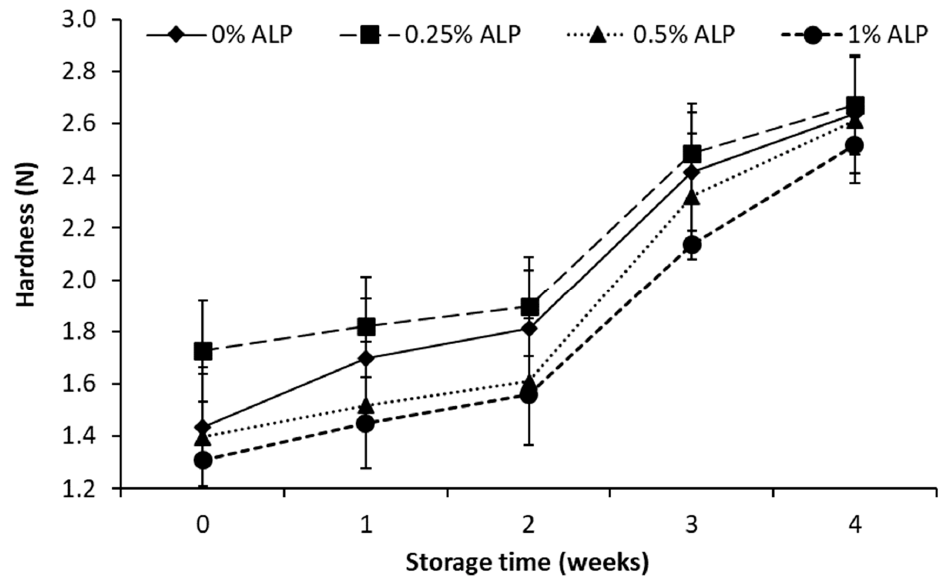
Figure 5. Hardness of acid curd cheese with different addition (0–1%) of astaxanthin lipid preparation (ALP) during 4 weeks of refrigerated storage (5 ± 1 ◦